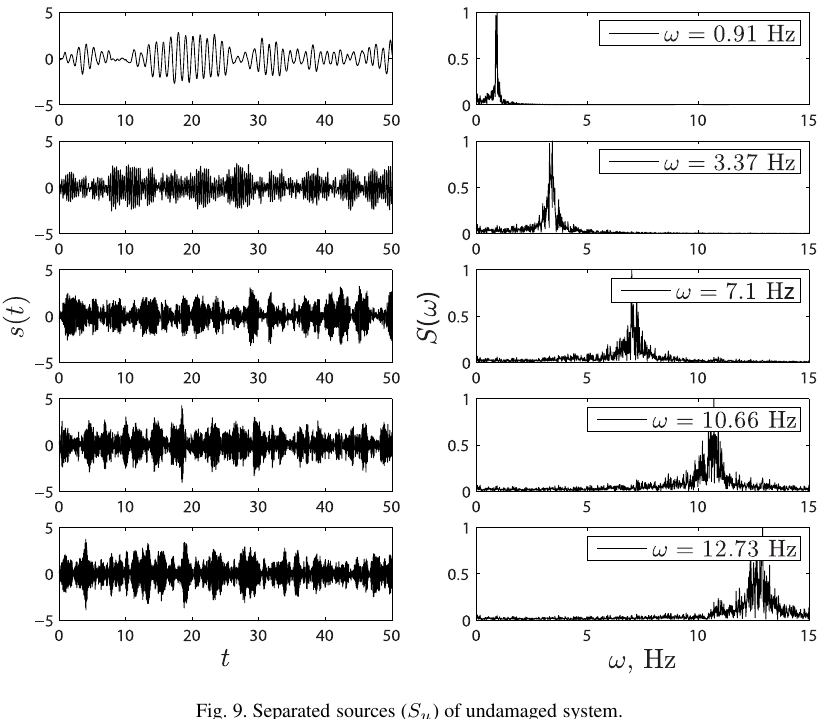
Fig. 9. Separated sources ( S u ) of undamaged system.